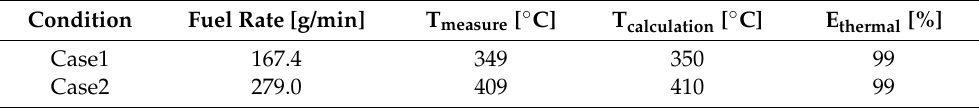
Table 6. Estimation of combustion efficiency by comparing measured and calculated temperature.